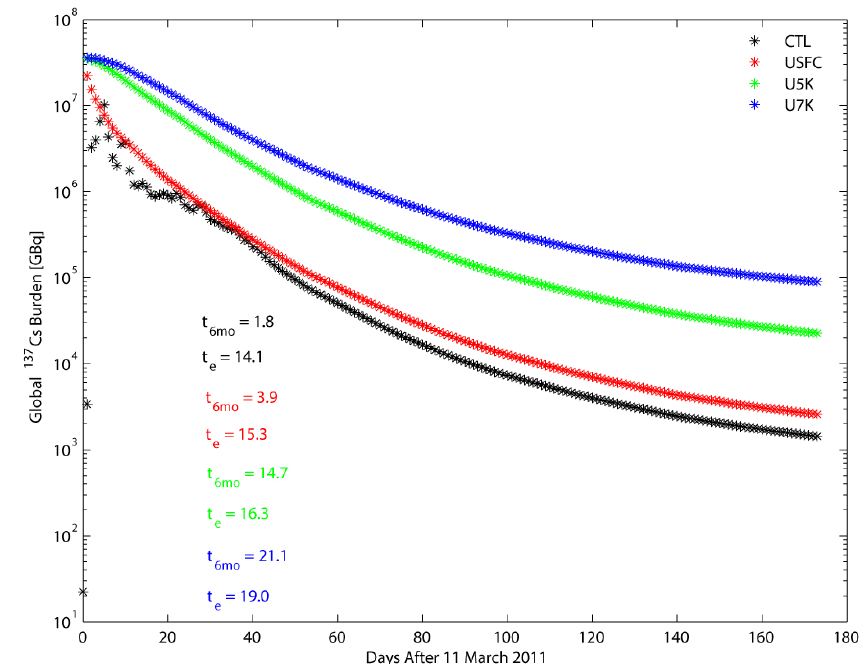
Fig. 2. Global 137 Cs burden for the four GEOS-Chem simulations of this study described in Table 1. The global 6-month mean lifetime ( τ 6mo ) and the e-folding time ( τ e ) in days fit over days 20 to 80 after 11 March 2011 are color coded to match the four simulations as indicated by the